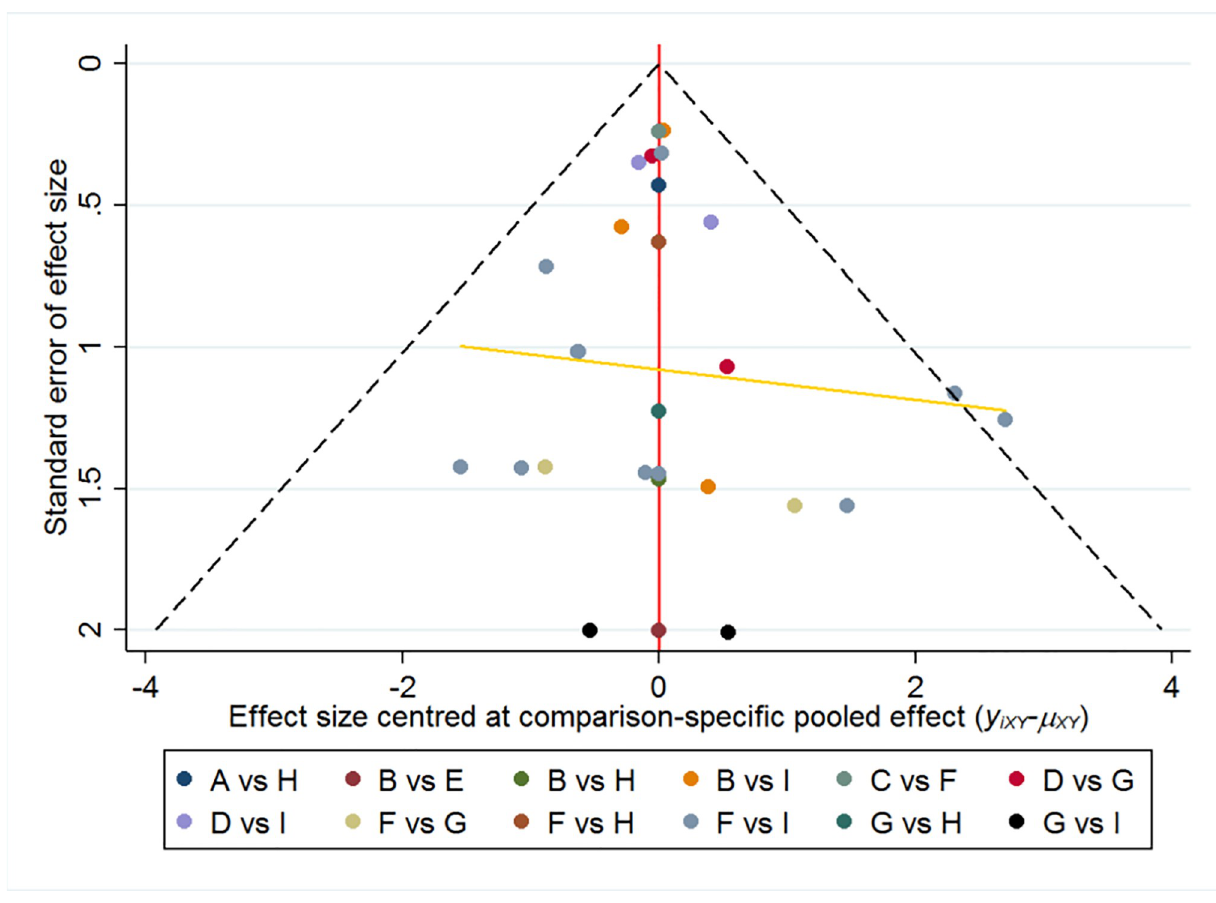
Fig 6. Correction funnel